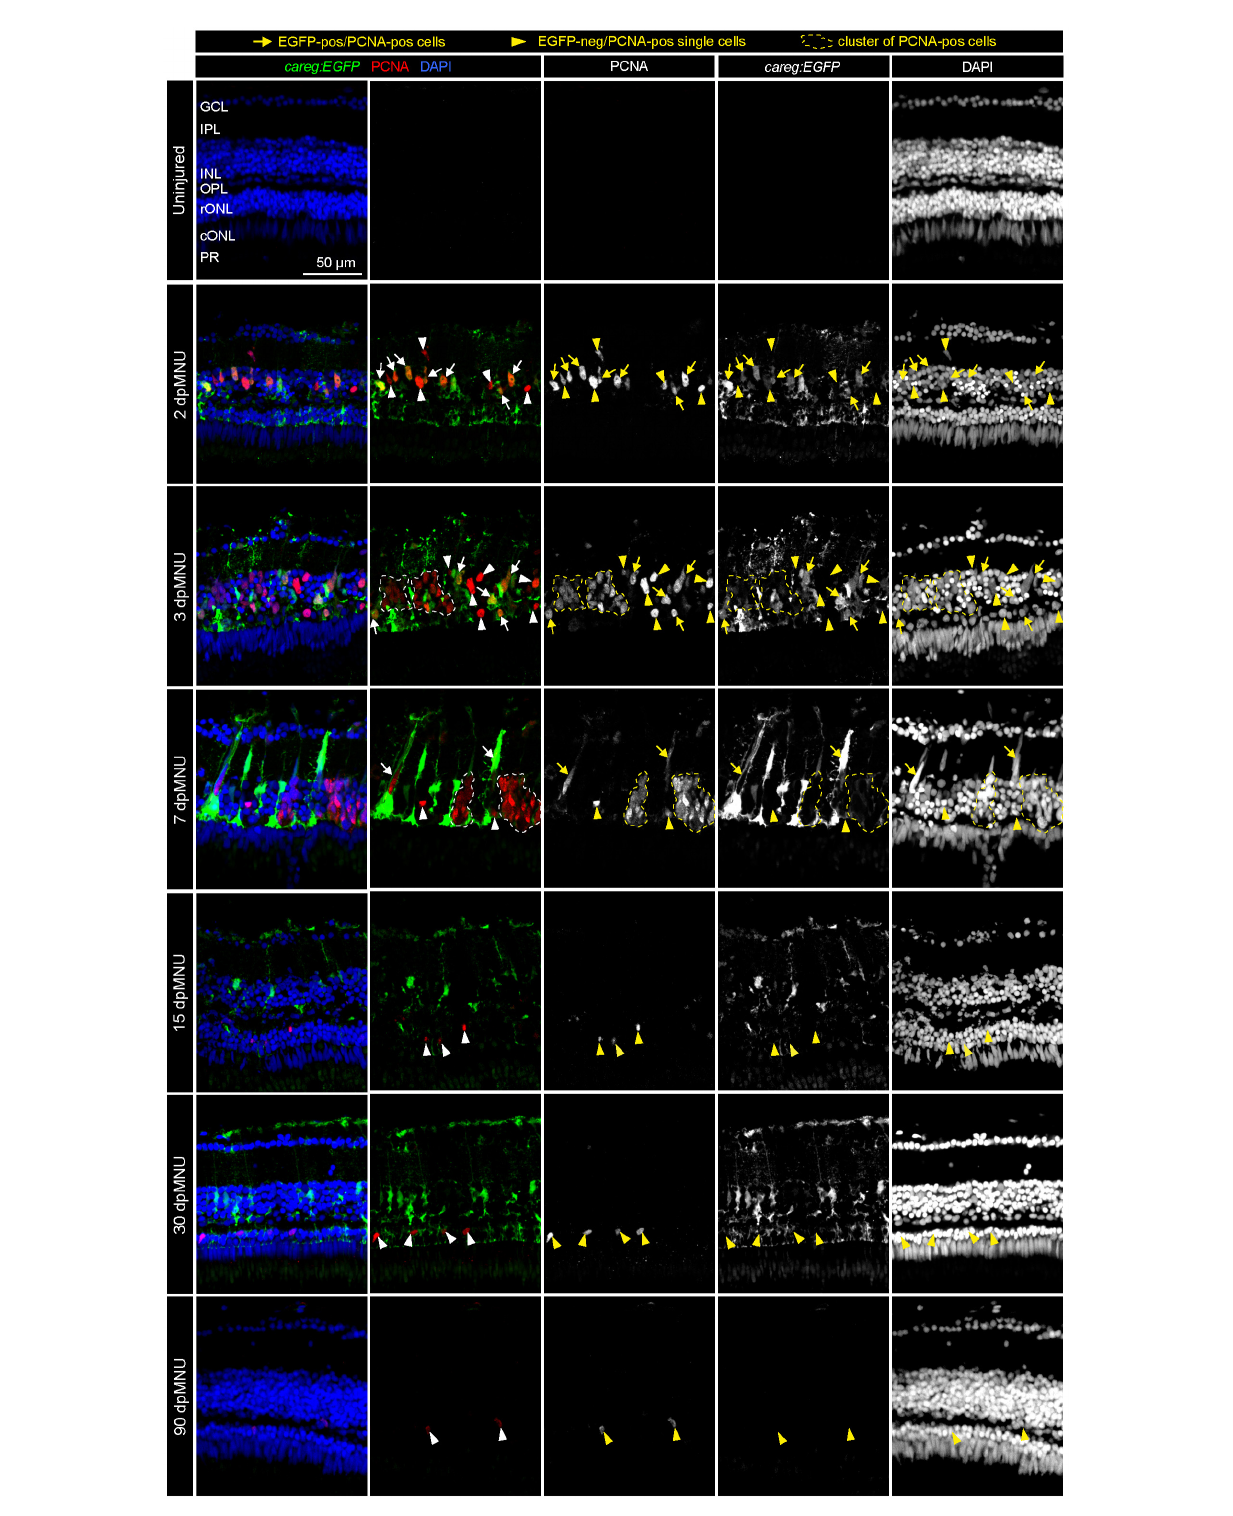
FIGURE2 Proliferative cells of regenerating retinas include careg:EGFP -positive cells with an elongated nuclei. Sections of careg:EGFP (green) retinas, immunostained for the G1/S-phase cell cycle marker PCNA (red) and the nuclear marker DAPI (blue). Expression of careg:EGFP (green) is absent in the uninjured retina, but it is induced at 2 dpMNU and persists until 30 dpMNU. In the inner nuclear layer (INL), EGFP/PCNA double positive cells with an elongated nucleus (arrows) can be observed at 2, 3, and 7 dpMNU. Single EGFP-negative and PCNA-positive cells with roundish nuclei (arrowheads) are observed at all time-points after injury. Clusters of EGFP-negative and PCNA-positive cells (encircled with a dashed line) correspond to progenitor cells at 3 and 7 dpMNU. At 15 and 30 dpMNU, PCNA-positive cells are present in the outer nuclear layer (ONL). At 90 dpMNU, no EGFP-positive cells are detected. GCL, ganglion cell layer; IPL, inner plexiform layer; INL, inner nuclear layer; OPL, outer plexiform layer; rONL, rod outer nuclear layer; cONL, cone outer nuclear layer; PRL, photoreceptors layer. N ≥ 3 (number of